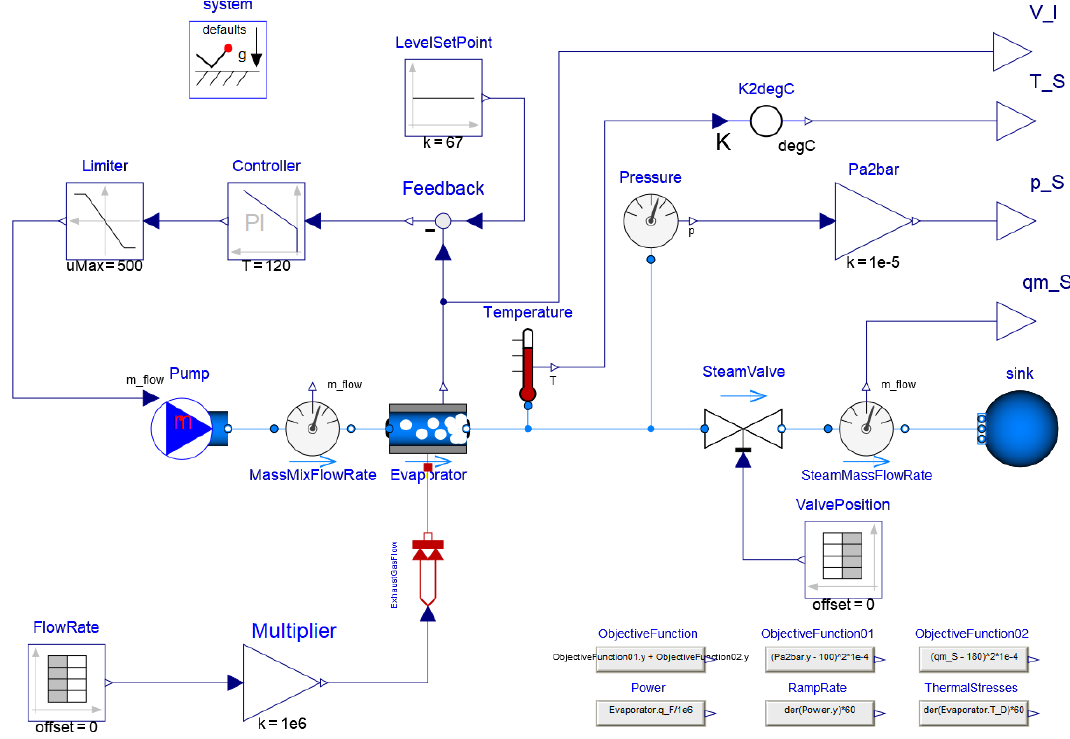
Figure 13. Drum boiler simulator: